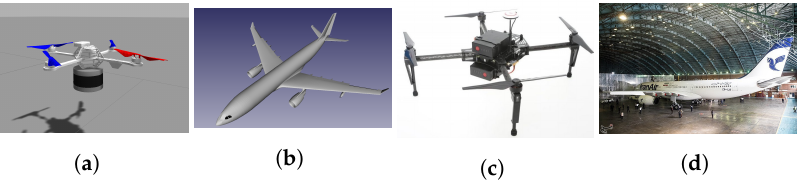
Figure 6. Components used in the simulation ( a , b ), and real flights ( c , d ). ( a ) Velodyne sensor and Hummingbird UAV. ( b ) Aircraft Airbus A330 model. ( c ) Three-dimensional LIDAR Ouster and DJI Matrice 100 UAV. ( d ) Airbus A330